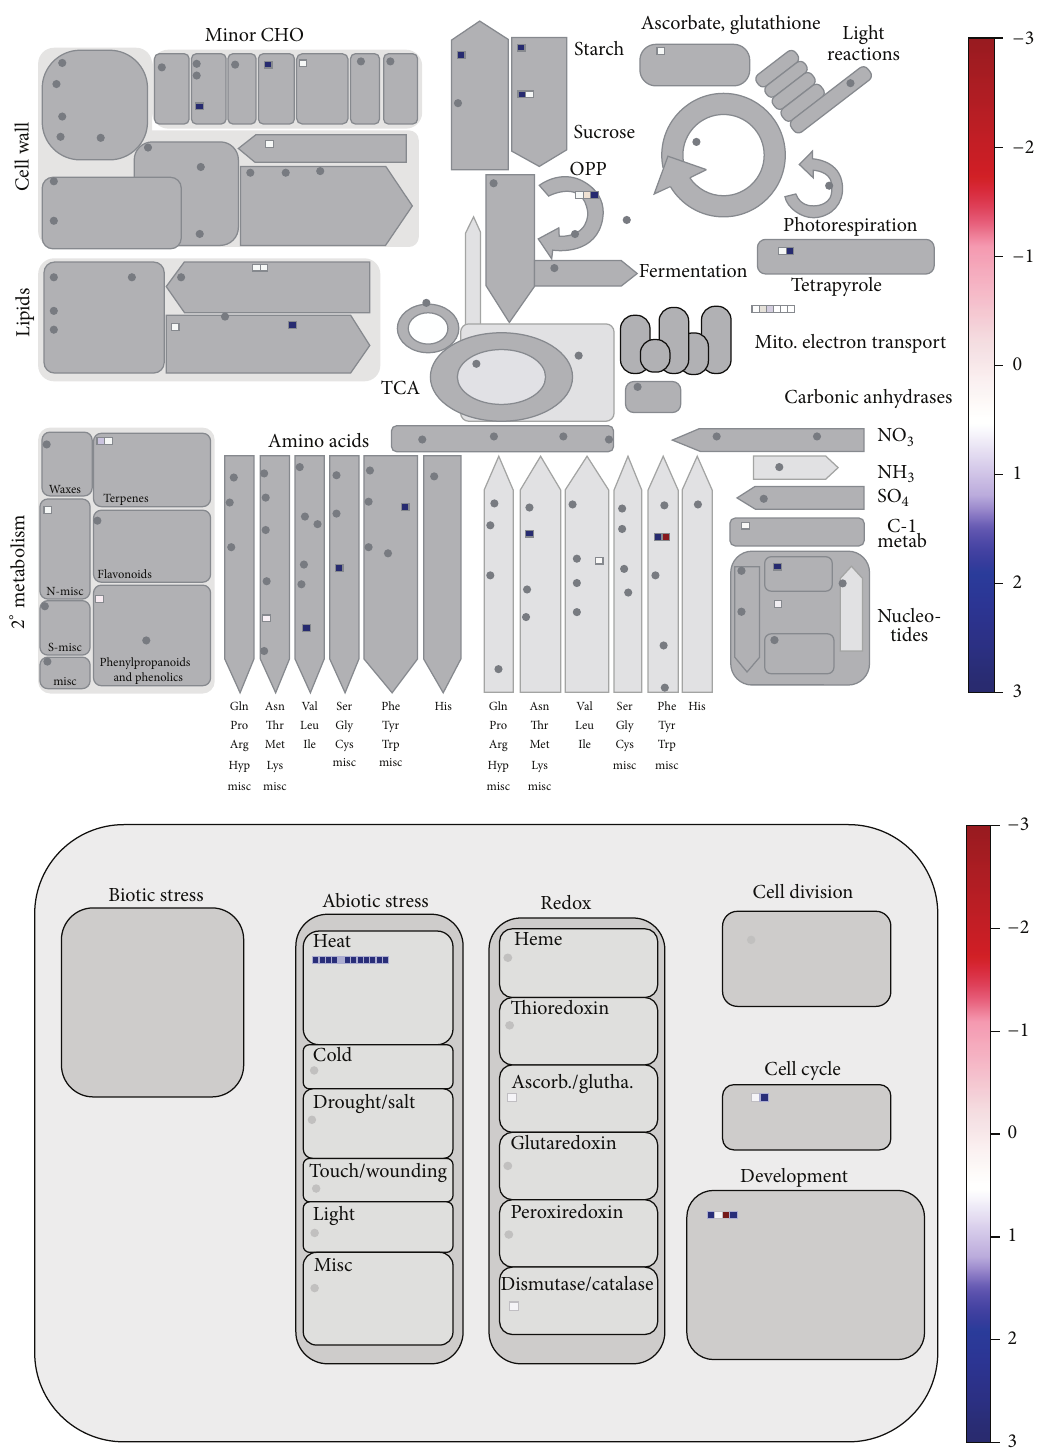
Figure 3: Mapman analysis for expression pattern of the differentially expressed proteins responding to heat